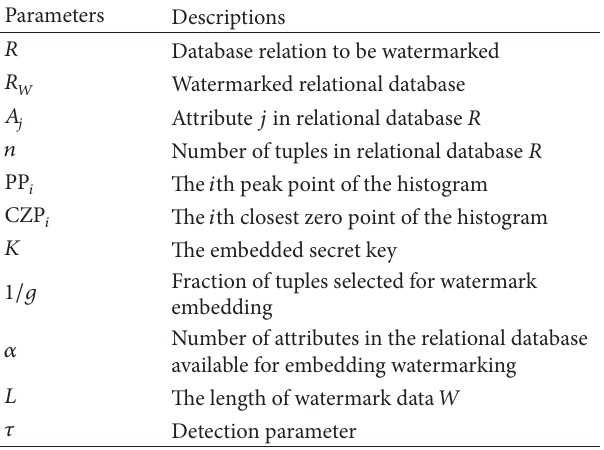
Table 1: Notations used in our